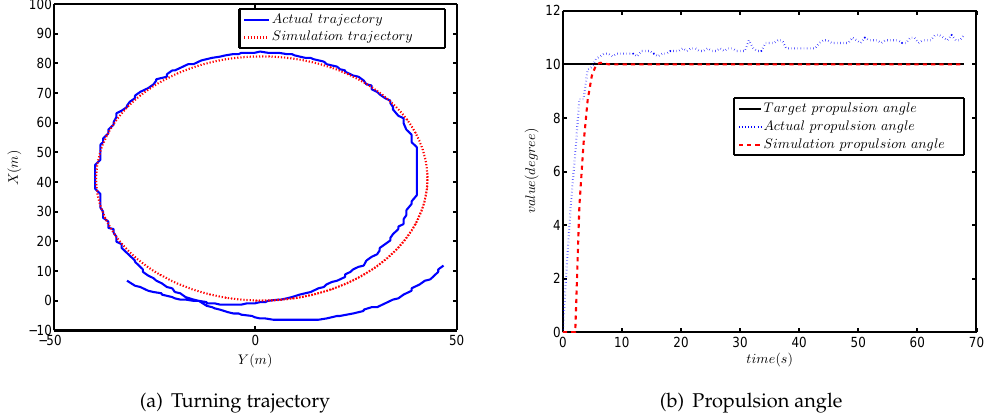
Figure 10. The comparison results of the turning